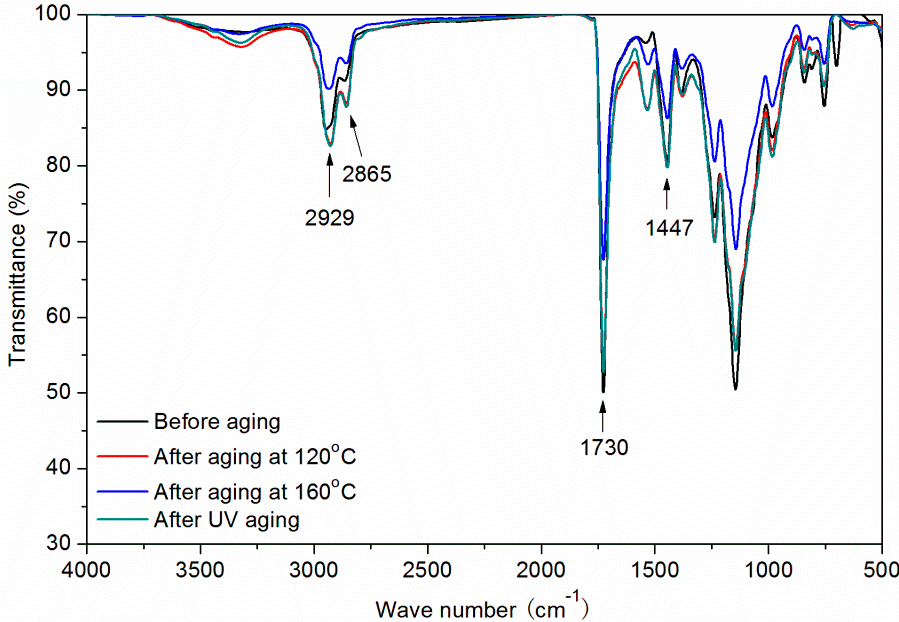
Figure 15. FTIR of the paint film without microcapsules before and after aging.